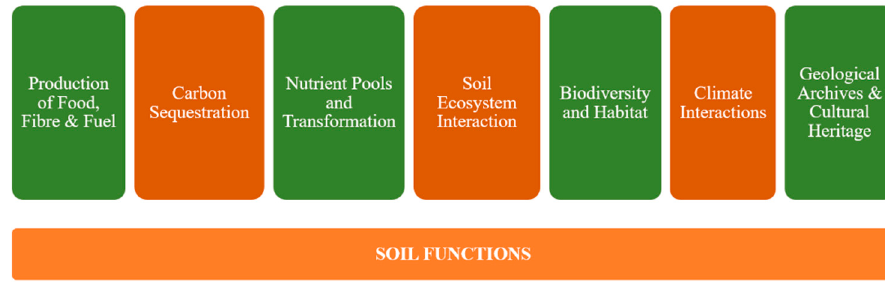
Figure 1. Seven functions of